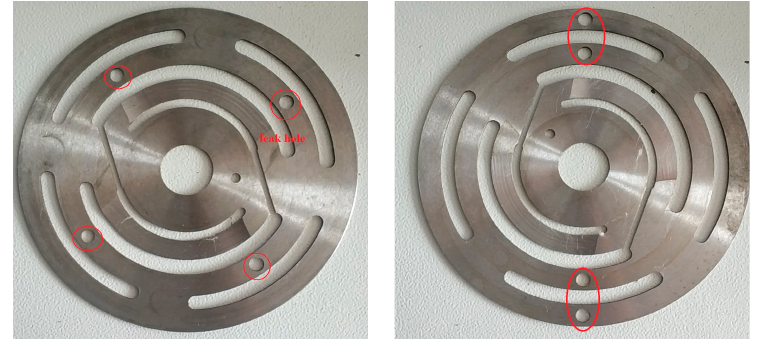
Figure 22. Suction valve plate leakage hole.